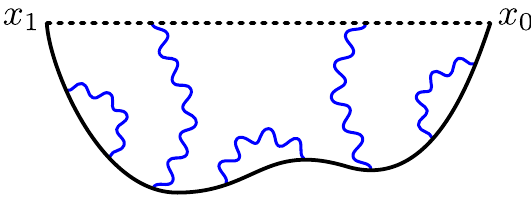
Figure 3 . An example of a planar diagram with three gluon exchanges (wiggled blue lines) on the Wilson line (black solid curved line) and two gluon exchanges between the Wilson line and the scalar propagator (dashed straight line). Only the gluon exchanges on the Wilson line contribute to the anomalous